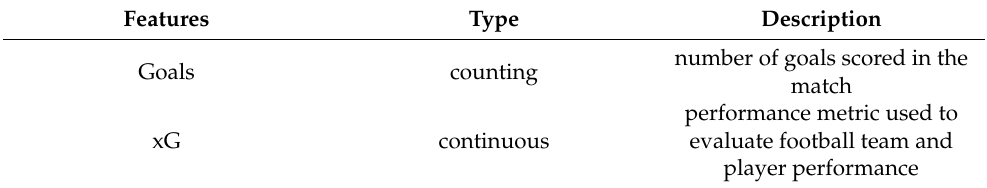
Table 5. Details of the